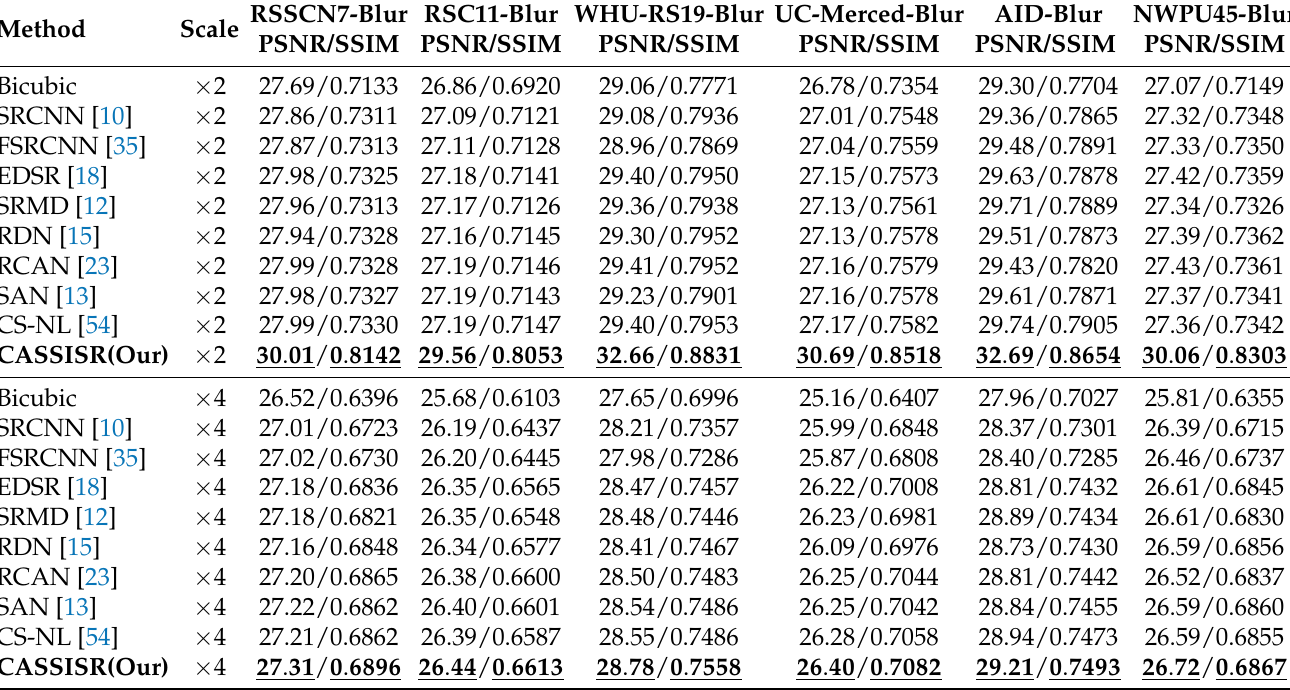
Table 2. The quantitative results of CASSISR and CNN-based SR methods on a ‘non-ideal’ remote sensing dataset (random Gaussian kernel downsampling). Our CASSISR results are highlighted , and the best results are underlined. Our CASSISR performs the